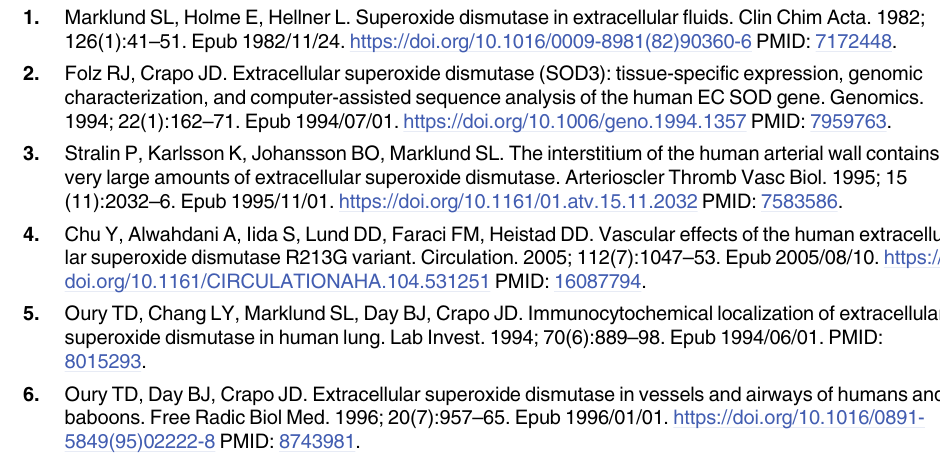
S1 Table. List of proteins that interact with SOD3 neutrophils in response to